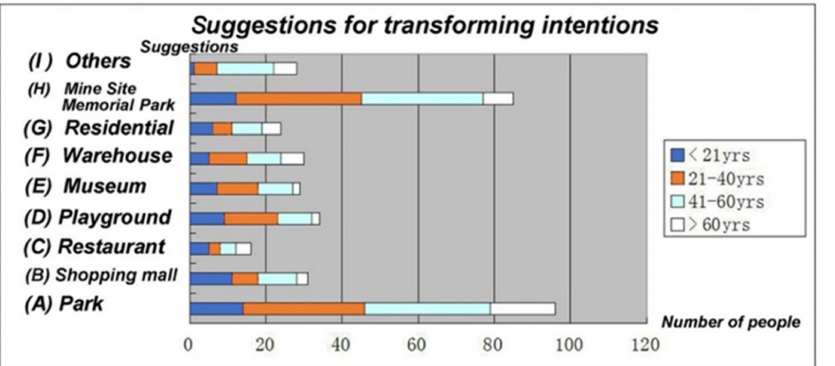
Figure 10. Residents’ hopes for transforming the mining